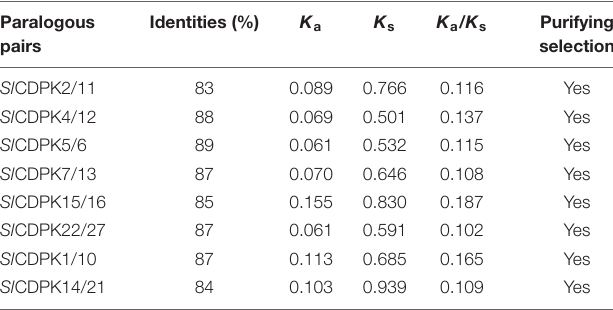
TABLE 2 | K a / K s ratios reflected in CDPK paralogous pairs. Paralogous